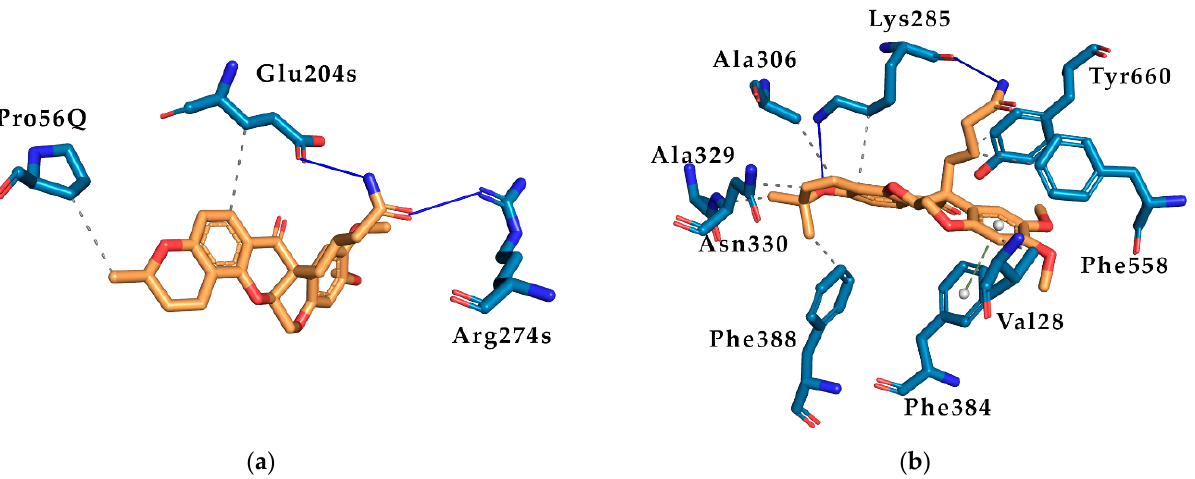
Figure 8. PLIP Ligand-Protein interaction of the deguelin derivative 12.11_14. ( a ) Detail of the interactions between the binding site of human NUO (5XTD) and the ligand 12.11_14; ( b ) detail of the interactions between the binding site of Leishmania ODC and the ligand 12.11_14. Orange—12.11_14 ligand. Dark blue—protein residues. Green— π -stacking interaction. Blue—hydrogen bonds. Grey—hydrophobic